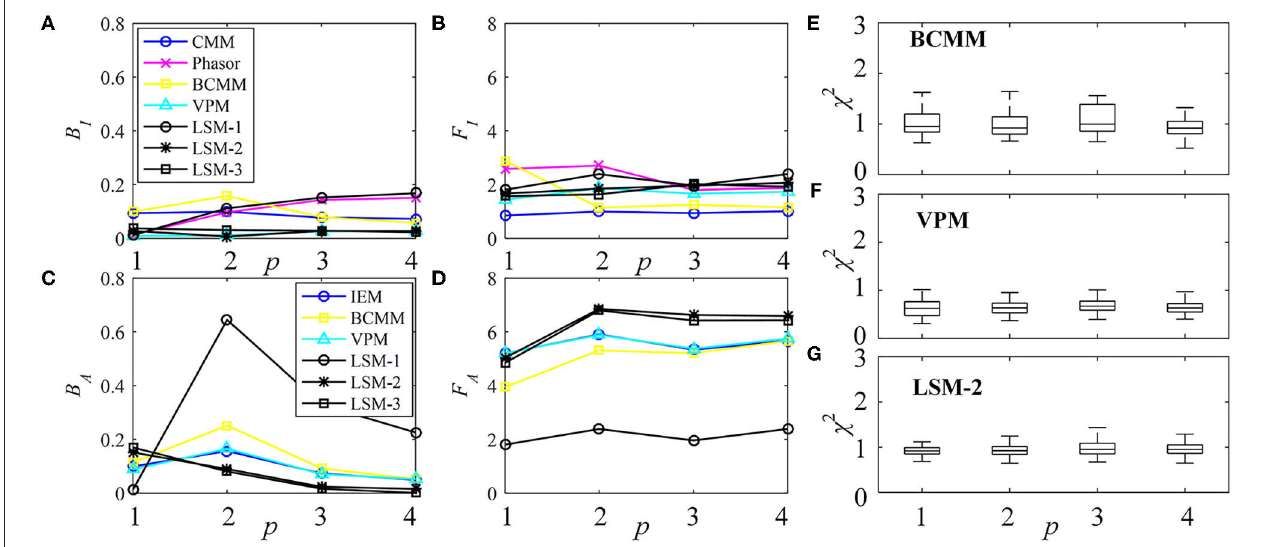
FIGURE 3 | Performances of τ I and τ A estimations with exponential decay signals using different algorithms, (A) B I , (B) F I , (C) B A , and (D) F A . (E–G) Box plots of χ 2 for BCMM, VPM, and LSM-2.